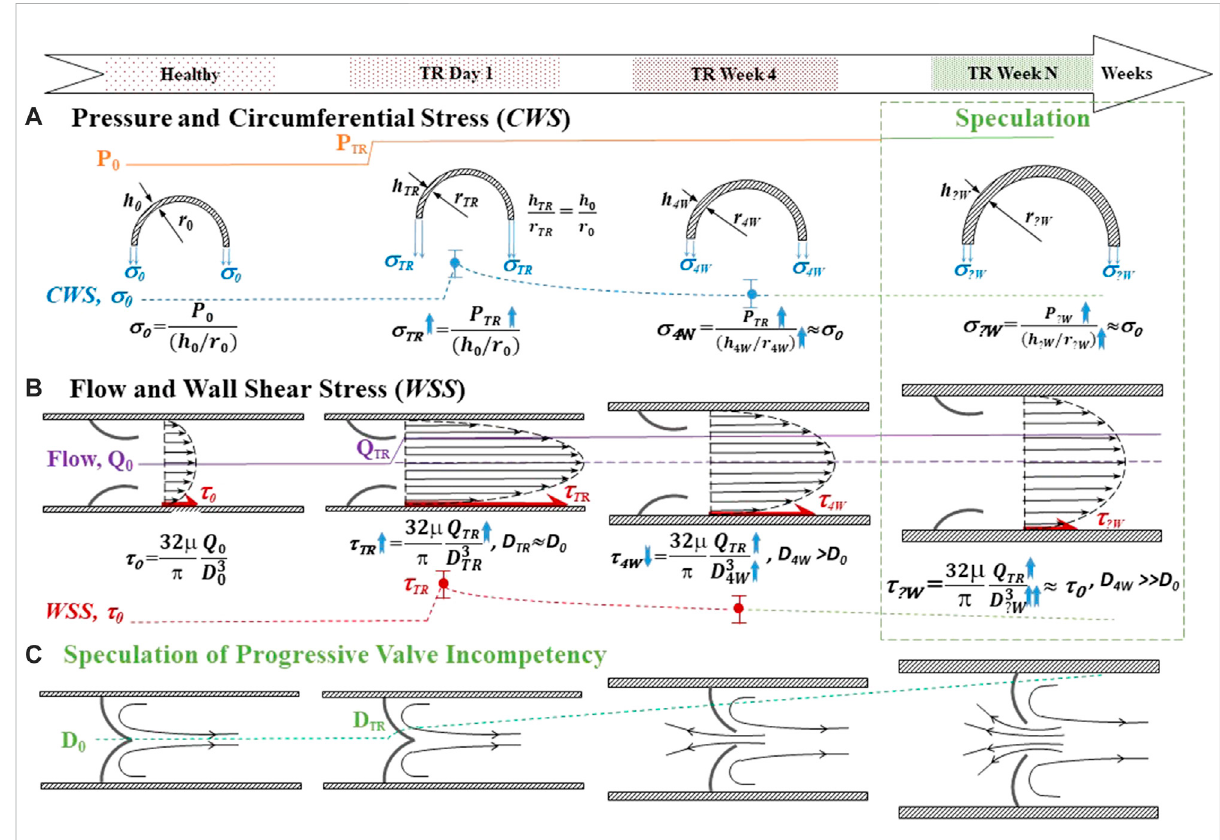
FIGURE 6 Schematic for integration of the fl uidodynamic and geometric data of the TD and speculation of the long-term effect of post-TR surgery. Top panel: Time course. (A) Pressure and circumferential wall stress ( CWS ). The top represents the pressure rising in TR. The middle represents the transverse view of the TD when outward remodeling and wall thickening before, the onset of TR surgery, and 4 weeks post-TR surgery. The bottom represents the trend of CWS change with time course. (B) Flow rate and wall shear stress ( WSS ). The top represents the longitudinal view of the TD outward remodeling before, the onset of TR, and 4 weeks post-TR surgery. The bottom represents the trend of WSS change with time course. The column highlighted by the green box in Figures 6A,B represents our (logical) speculation on the remodeling and homeostasis of mechanical stresses exceeding 4 weeks post-TR surgery. (C) Speculation of progressive valve incompetency induced by outward remodeling: The longitudinal viewoftheoutwardremodelingoftheTDresultsinTDvalvemalfunction.TR:tricuspidregurgitation.P:Pressure.h:WallthicknessofTD.r:Radiusof TD. CWS ( σ ): Circumferential wall stress. Q: Lymph fl ow in TD. WSS ( τ ): Wall shear stress. D: Inner diameter of